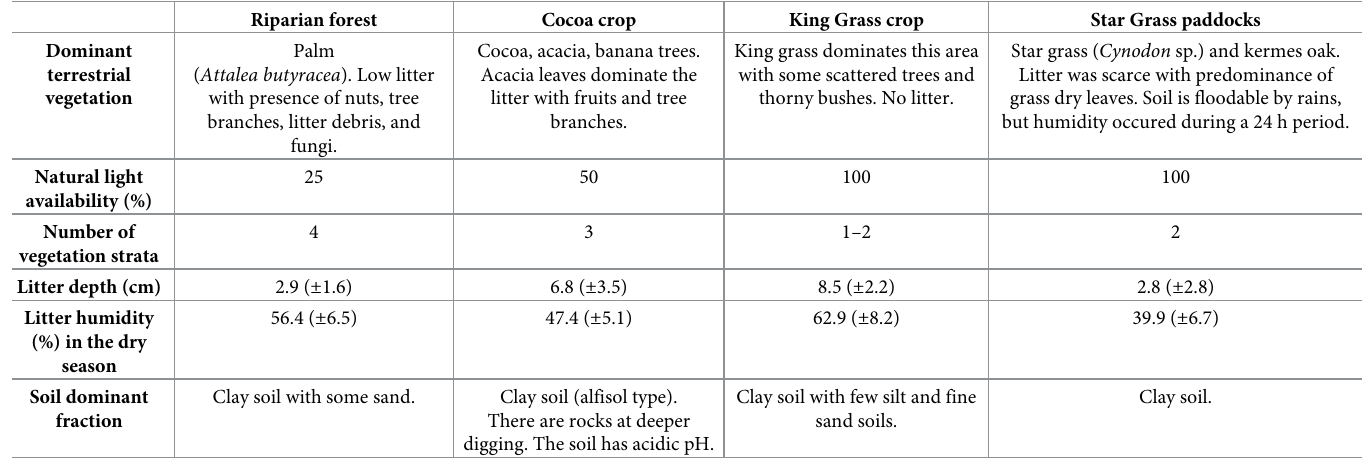
Table 1. Structural characteristics of the four habitats-selected where ticks were collected. Riparian forest Cocoa crop King Grass crop